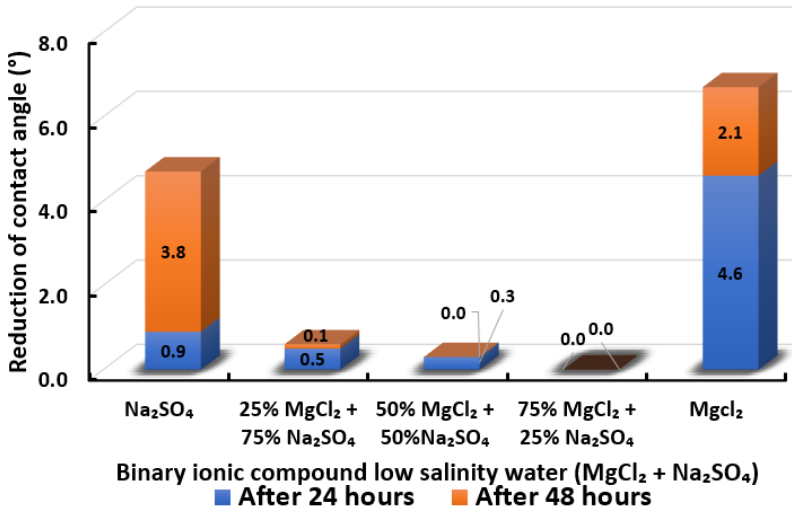
Figure 19. Contact angle reduction results for binary ionic compounds smart water (SW) solutions MgCl 2 + Na 2 SO 4 (3500 ppm).